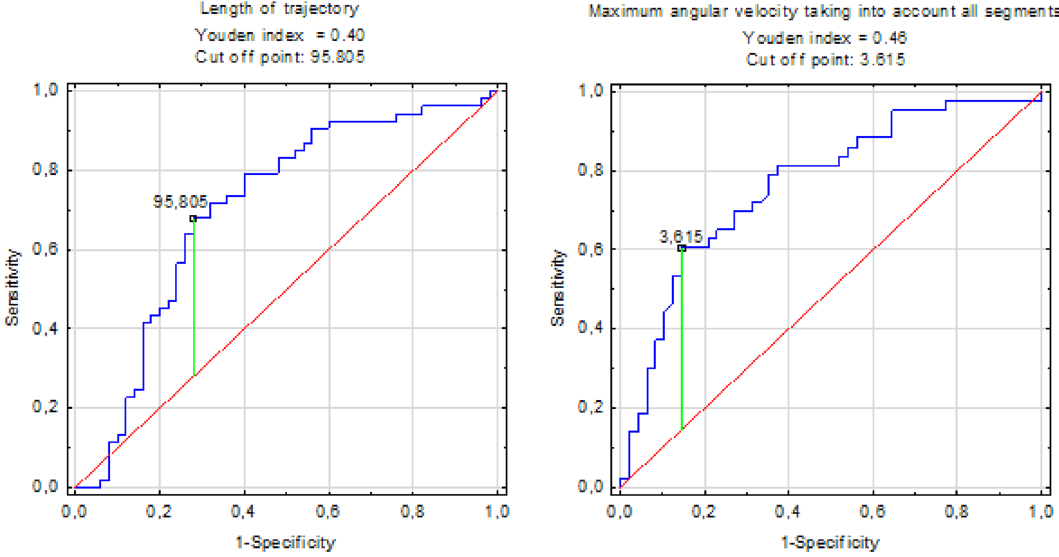
Figure 2. Example of obtained ROC